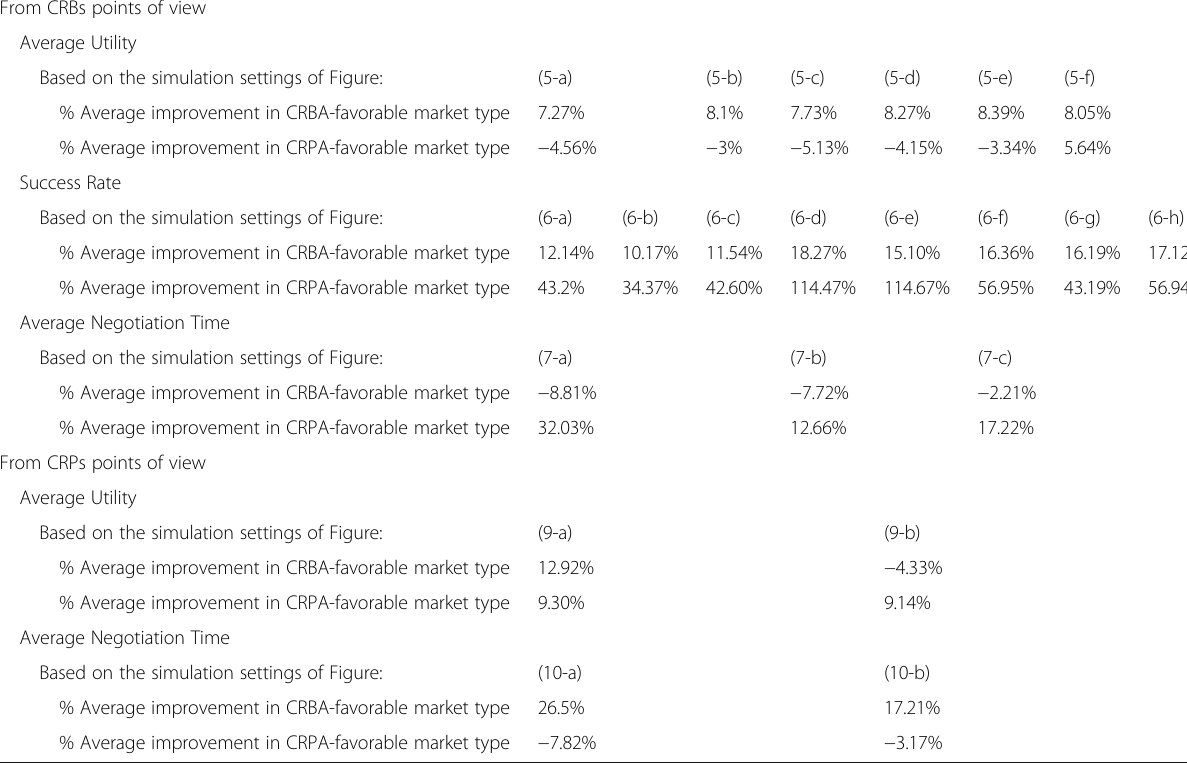
Table 10 A summary of the obtained results from Figs. 5, 6, 7, 9, and